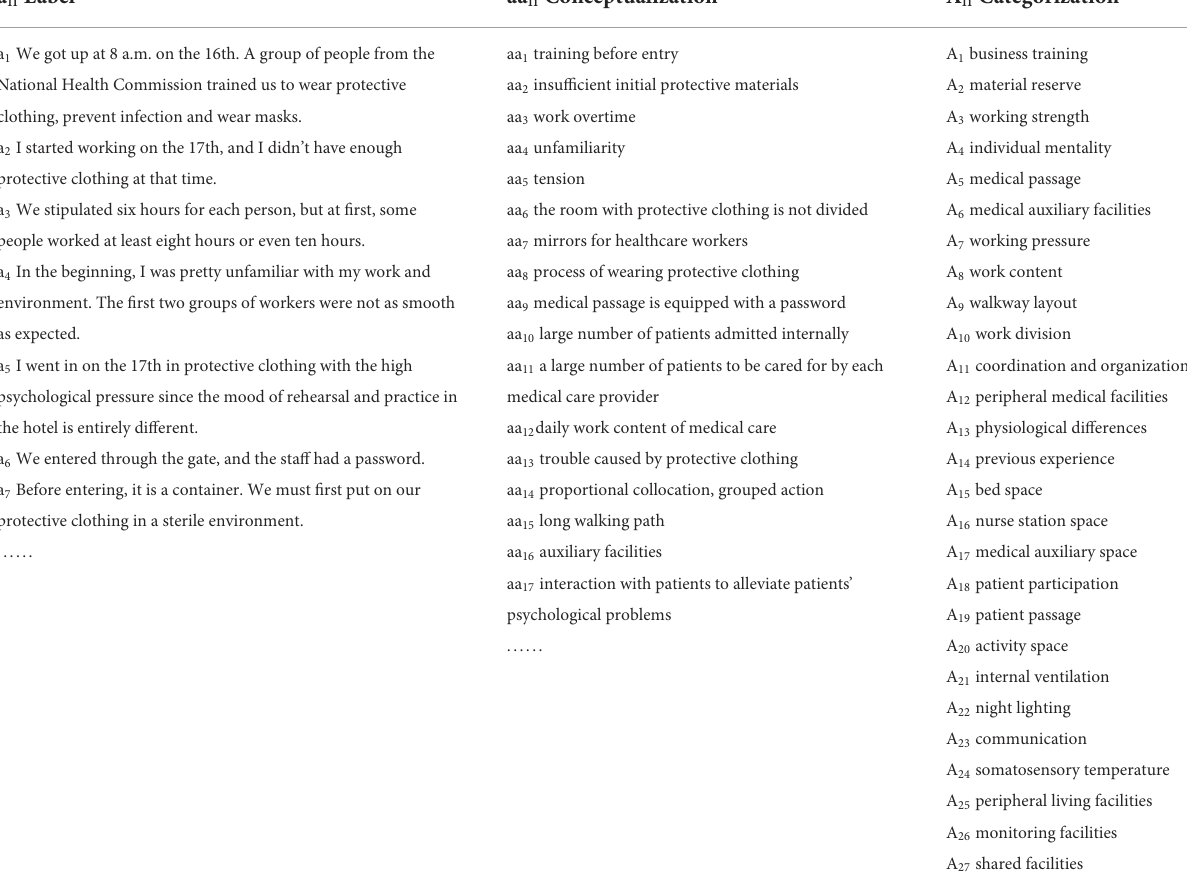
TABLE 2 Open coding